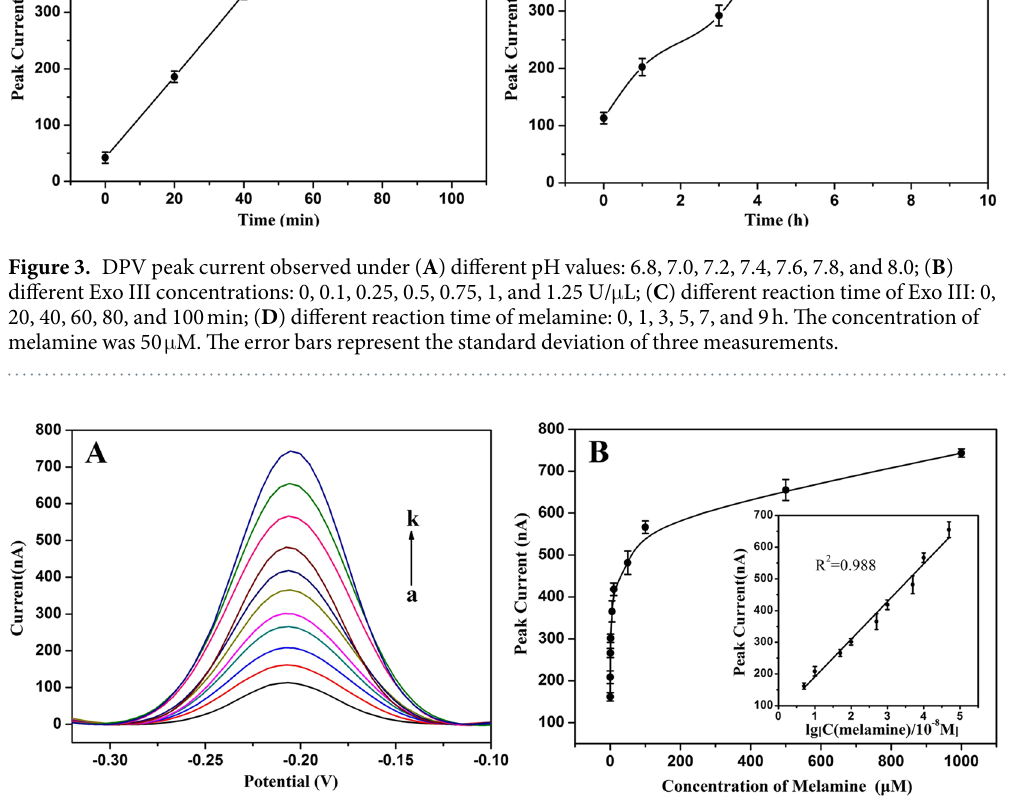
Figure 4. ( A ) DPV currents of the sensing system after adding melamine with different concentrations: (a–k) 0, 0.05, 0.1, 0.5, 1.0, 5.0, 10, 50, 100, 500, and 1,000 μ M, respectively. ( B ) Calibration curve corresponding to the peak current versus melamine concentration ranging from 50 nM to 1,000 μ M. Inset: the linear relationship between DPV peak current and melamine concentration ranging from 50 nM to 500 μ M. The error bars represent the standard deviation of three